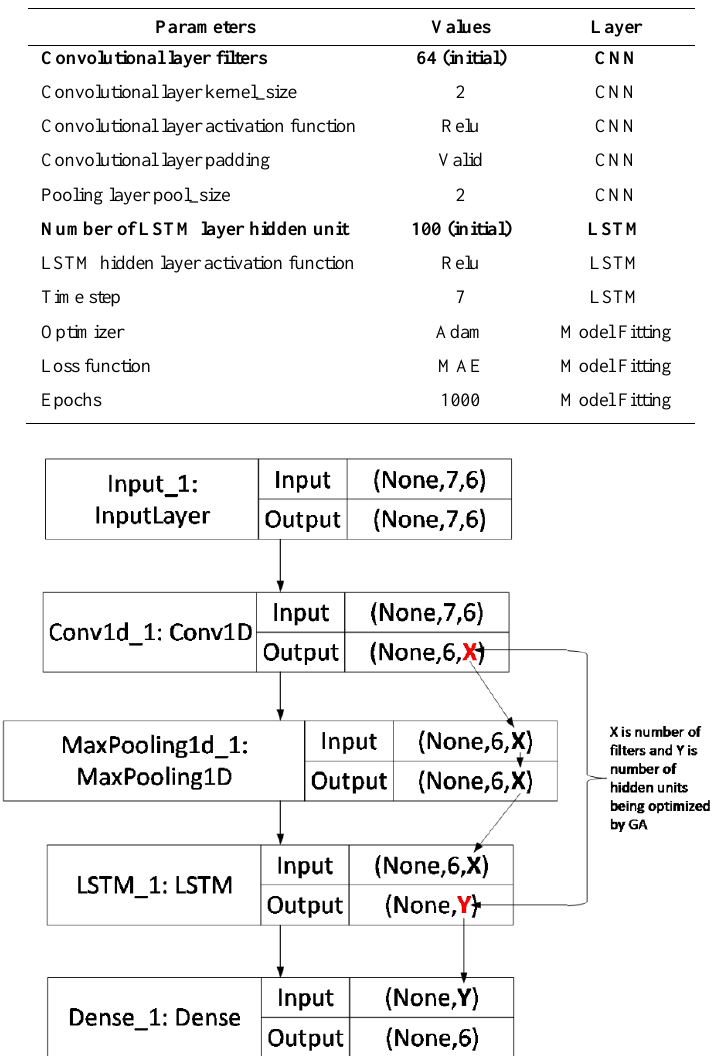
Figure 7. Architecture of the proposed GA CNN-LSTM model for multi-channel mobility prediction with 6 features and 7- time steps for the prediction